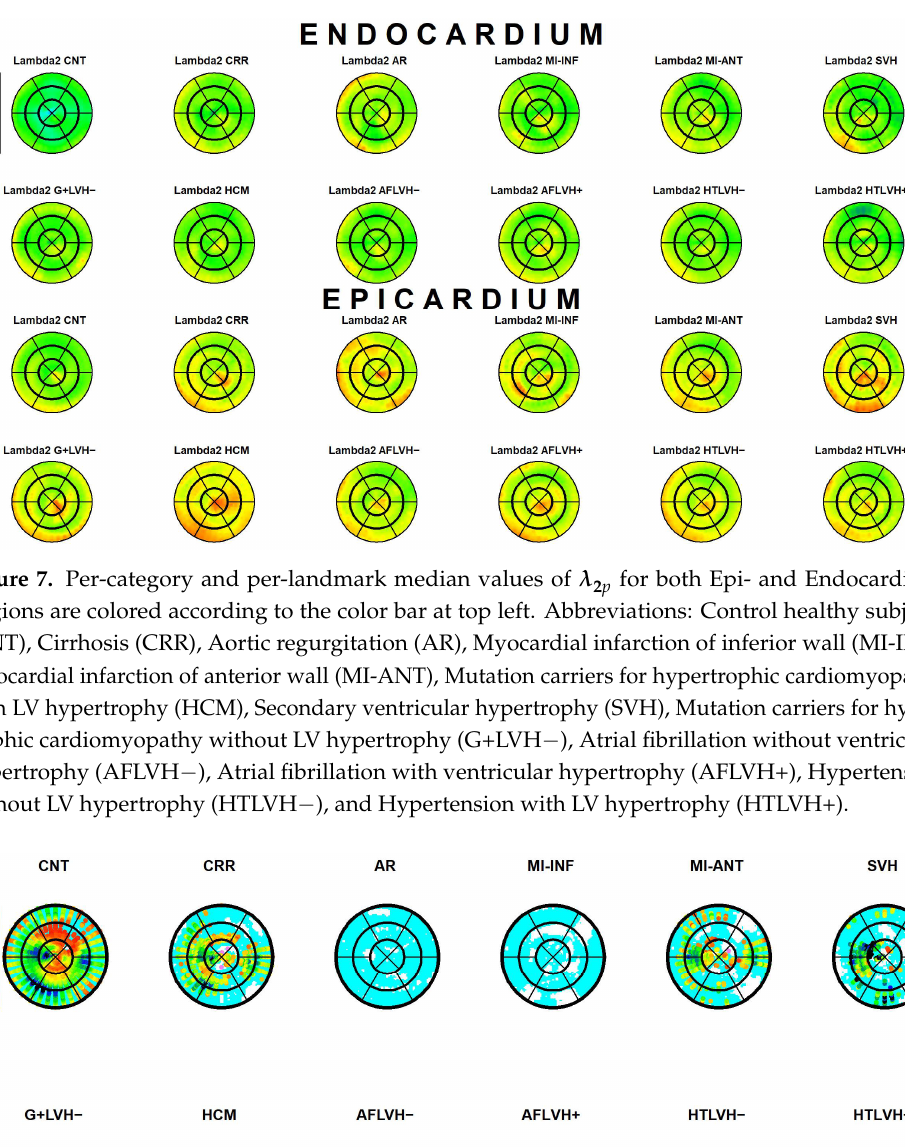
14 of 21 Figure 6. Per-category and per-landmark median values of λ 1 p for both Epi- and Endocardium. Regions are colored according to the color bar at top left. Abbreviations: Control healthy subjects